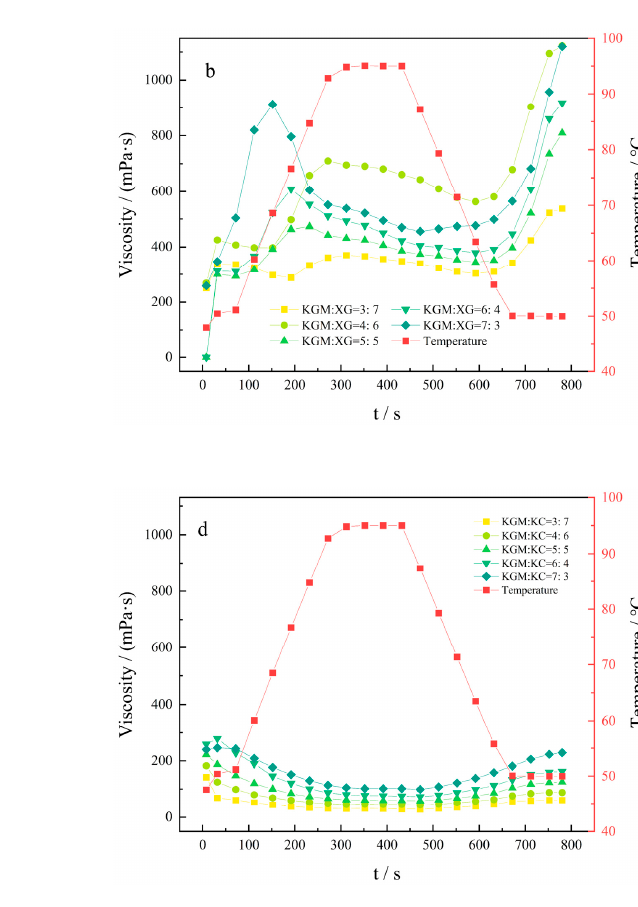
Figure 7. Viscosity curves of KGM and single thickener: ( a ) KGM mixed with GG; ( b ) KGM mixed with XG; ( c ) KGM mixed with LBG; ( d ) KGM mixed with